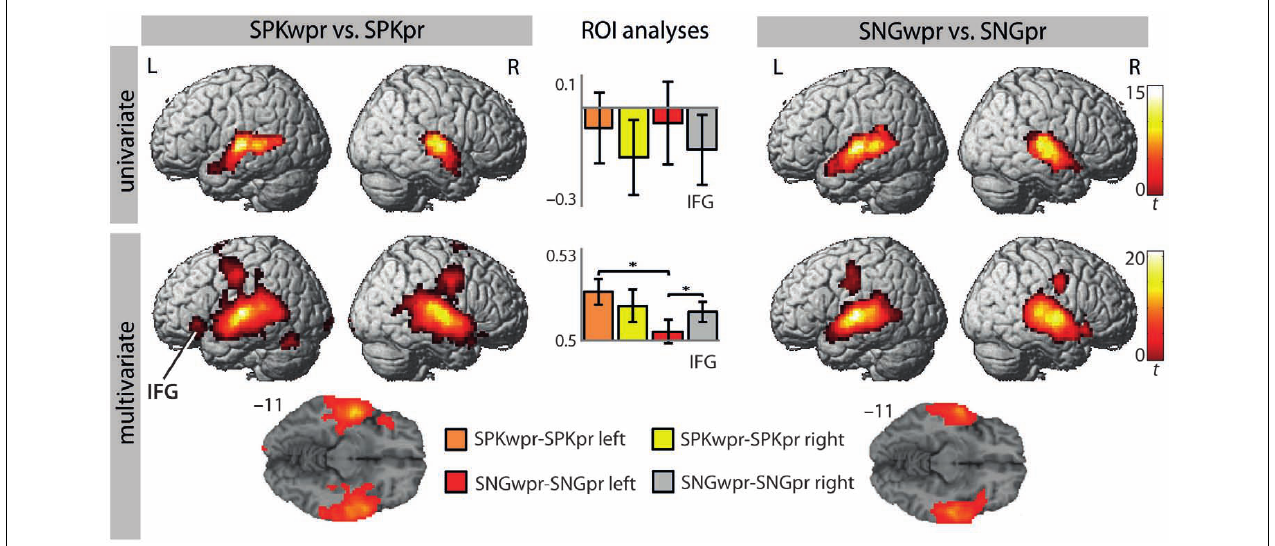
(UVA) and accuracy values (MVPA) of the shown contrasts extracted from left and right BA 47. Significant differences between conditions are indicated by an asterisk (* p < 0.05). Colour scales on the right indicate t -values for each row. IFG, inferior frontal